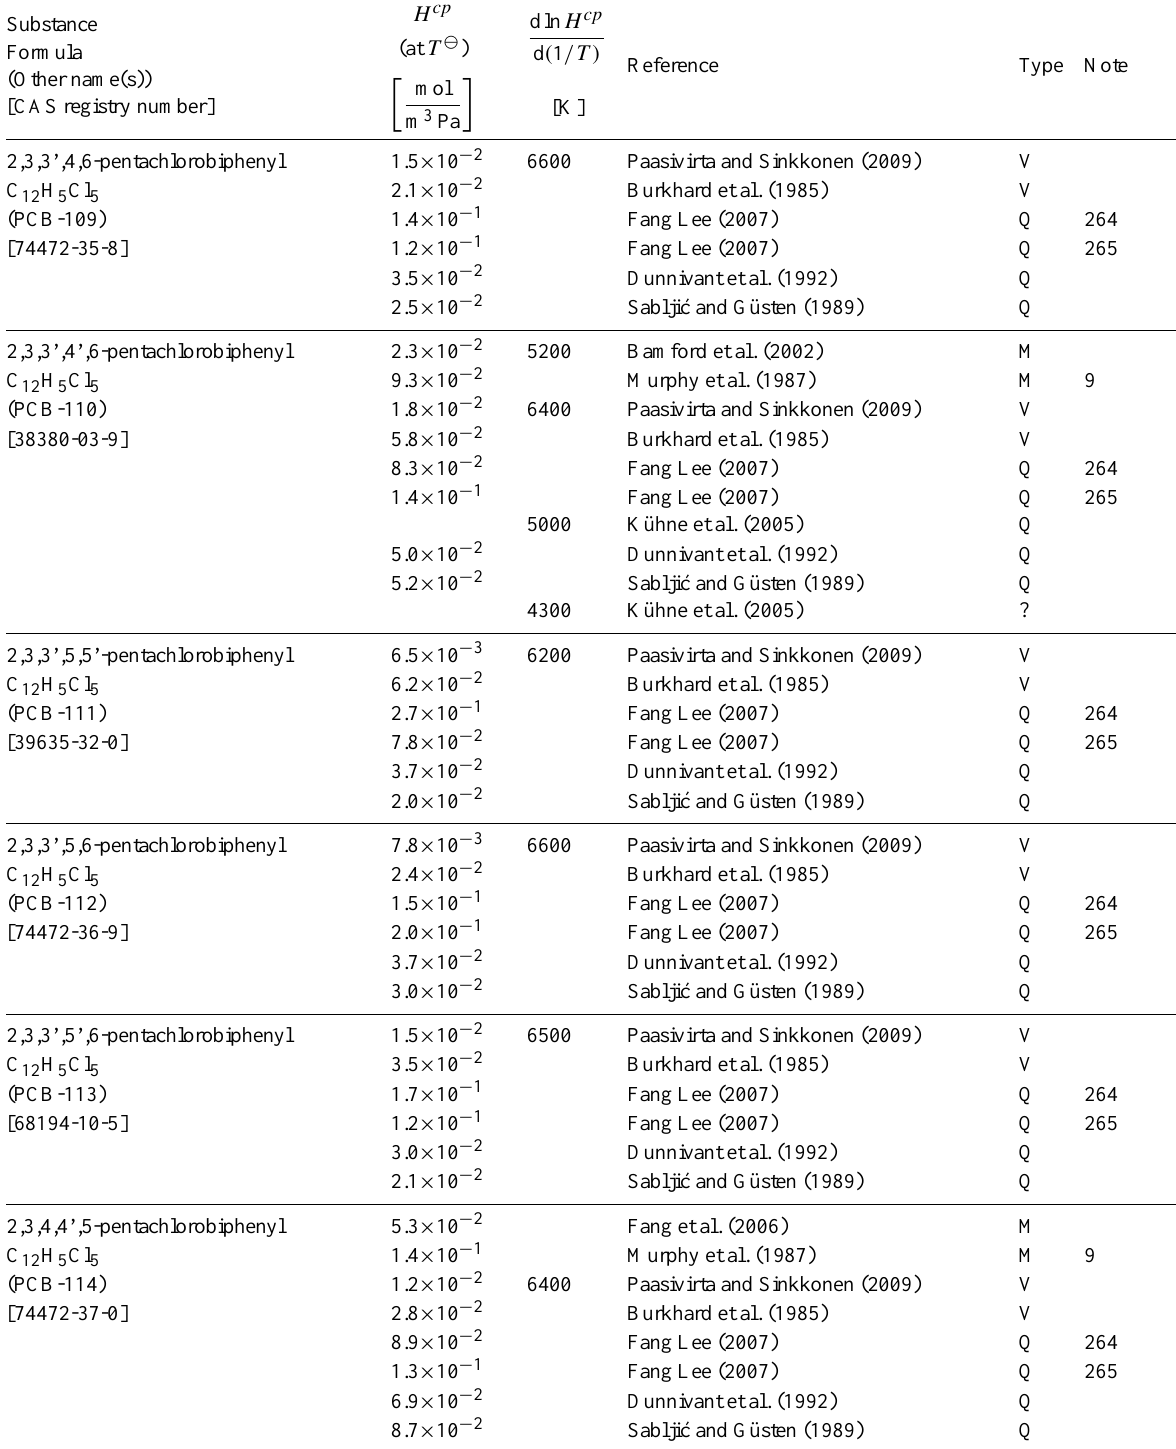
Table 6: Henry’s law constants for water as solvent